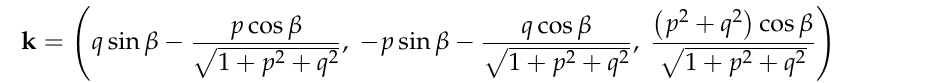
Figure 5. ( a ) A sketch of the laser incidence onto the inclined surface of the material and the decomposition of the electric field E i onto different planes; ( b ) An effective electric field vector on the x (cid:48) -y (cid:48) plane and its induced periodic ripple structures with the orientation vector k . In Equation (1), n and κ represent the real and the imaginary parts of the complex refractive index (cid:101) n of the material, respectively. Accordingly, the orientation vector of the ripple structures on the inclined surface, k , should be perpendicular to the direction of the electric field E Figure 5b. When the ripple orientation k in the x (cid:48) -y (cid:48) -z (cid:48) coordinate system is transferred into the X-Y-Z coordinate system, it should be modified